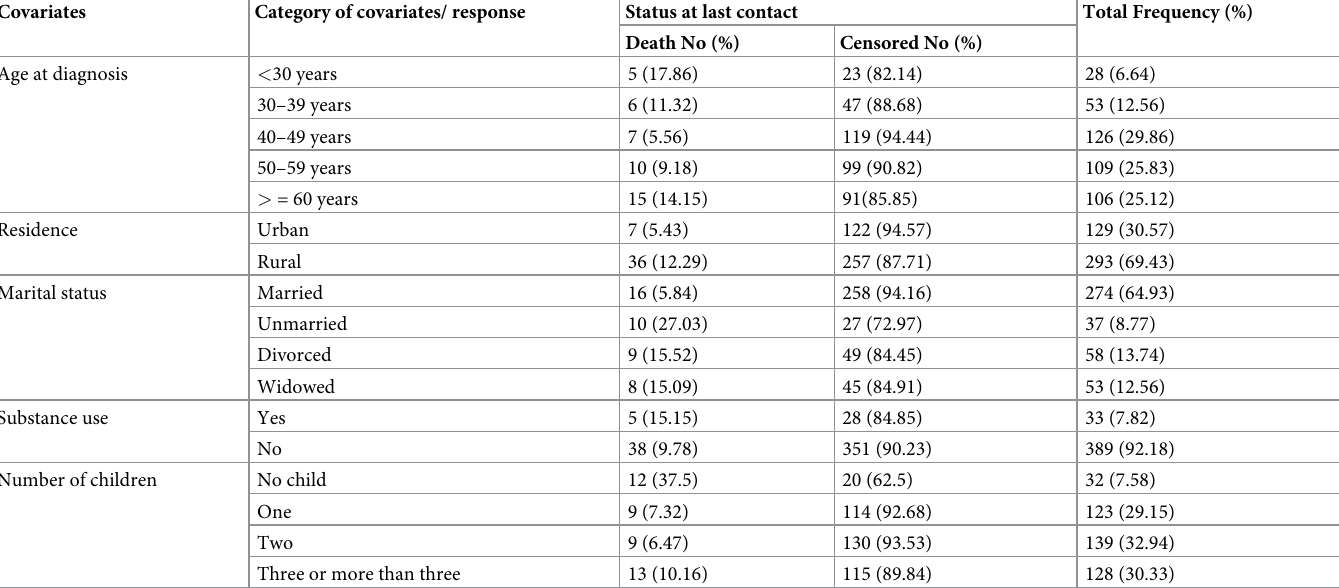
Table 2. Socio-demographic characteristics of cervical cancer patients in Felege Hiwot Comprehensive Specialized Hospital Oncology Center, Ethiopia (N = 422, March 2021).